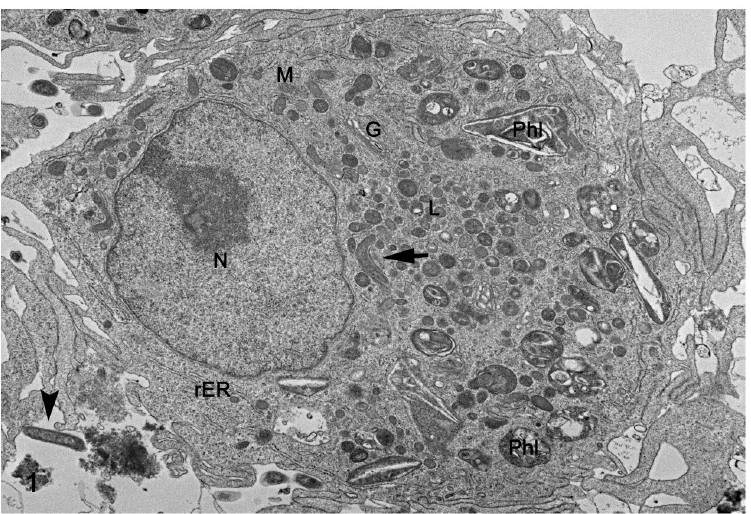
Fig 1. Monocyte-derived macrophage infected with Lawsonia intracellularis . Transmission electron microscopy. At one-hour post infection, L . intracellularis was observed in the proximity of the macrophage membrane (arrowhead) and free within the macrophage cytoplasm (black arrow). G: Golgi apparatus; L: lysosome; M: mitochondria; N: nucleus; Phl: phagolysosome; rER: rough endoplasmic reticulum.